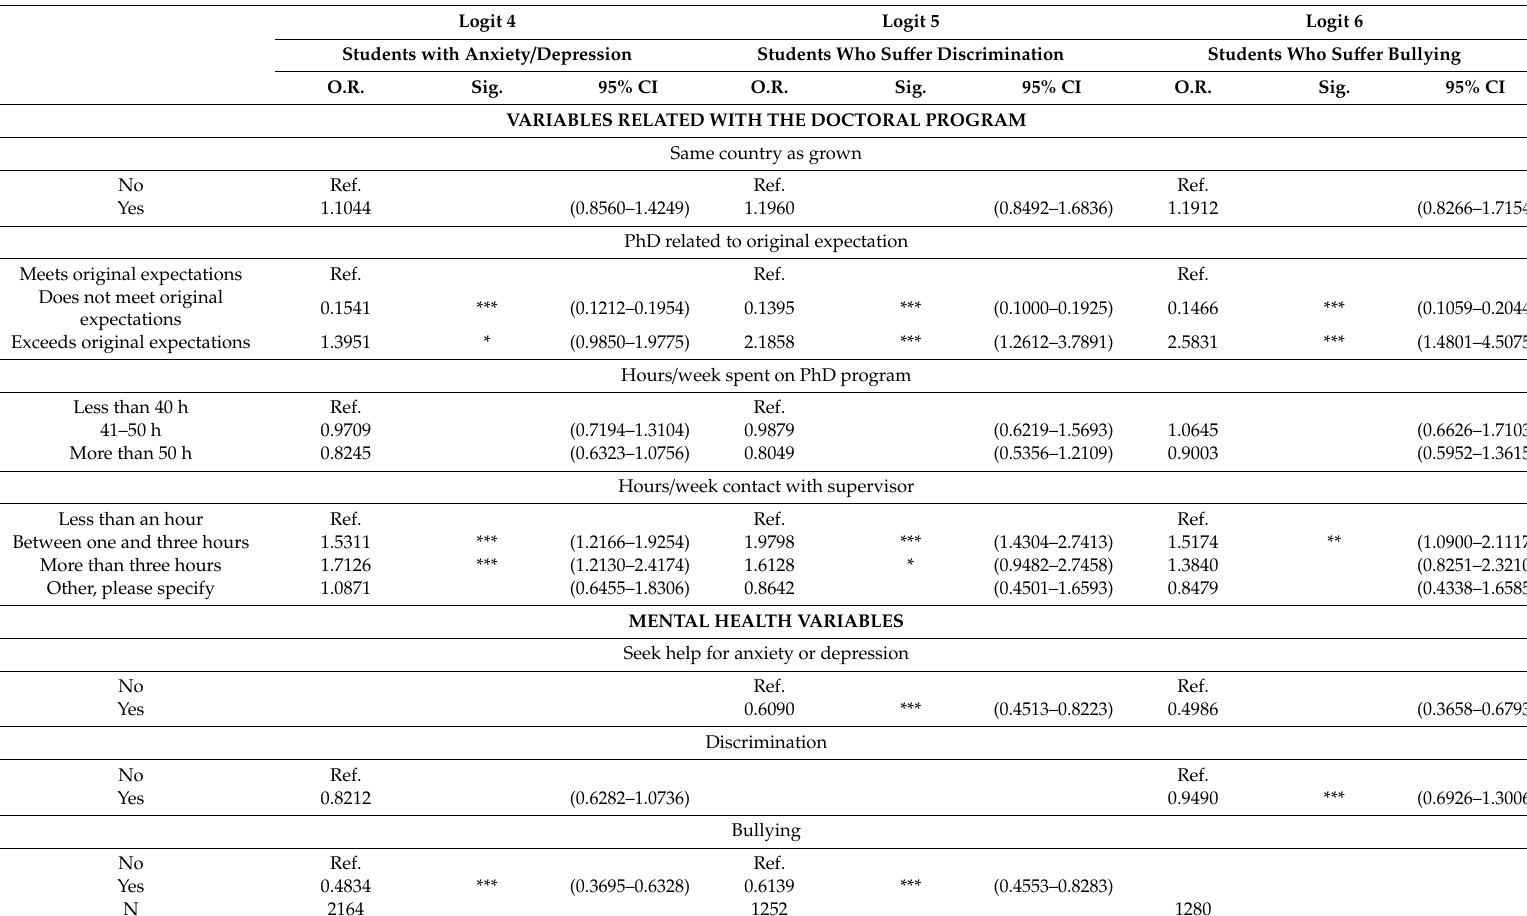
Table 2. Binomial logistic regressions (endogenous variable: Do nothing vs. Change area / supervisor / not pursue a PhD)—Subsample: Students with mental health